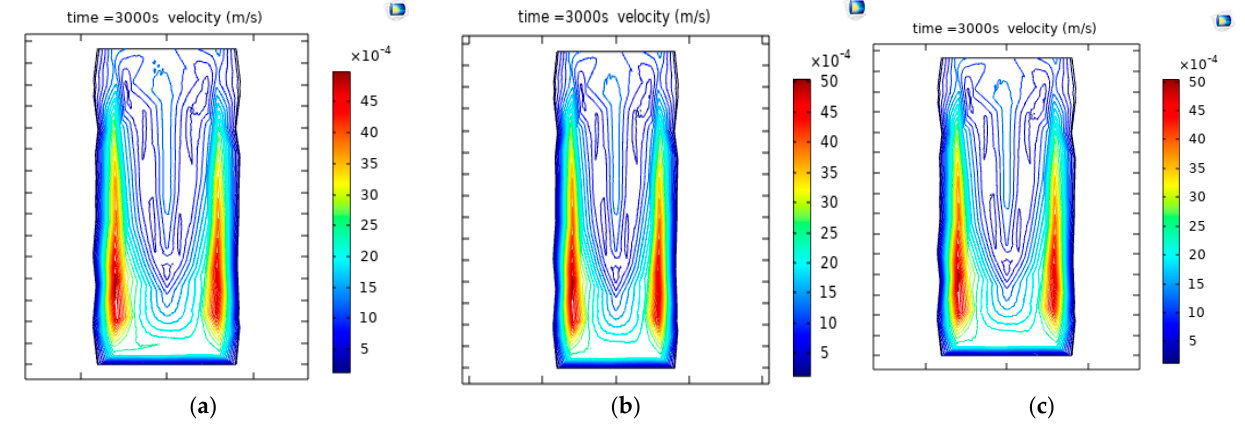
Figure 11. Velocity fields inside the reactor at 3000 s after the onset of the HTC process: Effect of the imposed wall heat flux, ( a ) q 0 = 2.0 kW; ( b ) q 0 = 2.3 kW; ( c ) q 0 = 3.0 kW.